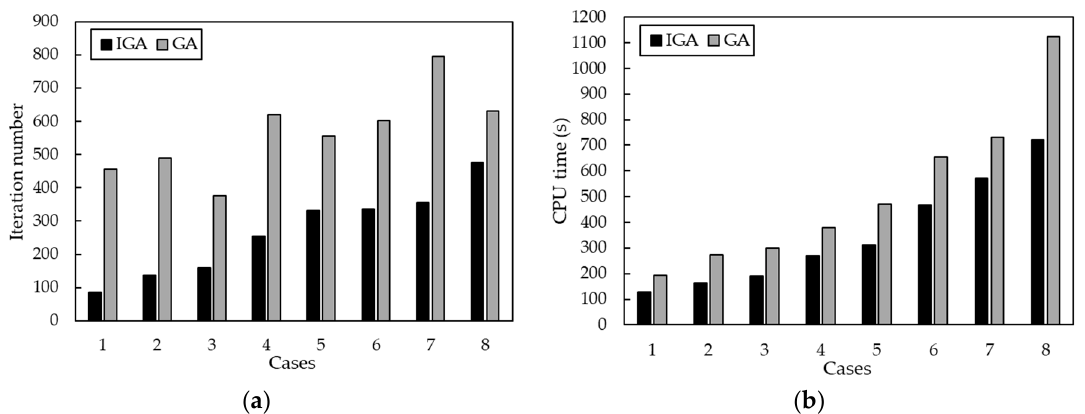
Figure 10. Comparison of computational performance between GA and IGA. ( a ) Comparison of iteration number between GA and IGA; ( b ) comparison of CPU time between GA and IGA.